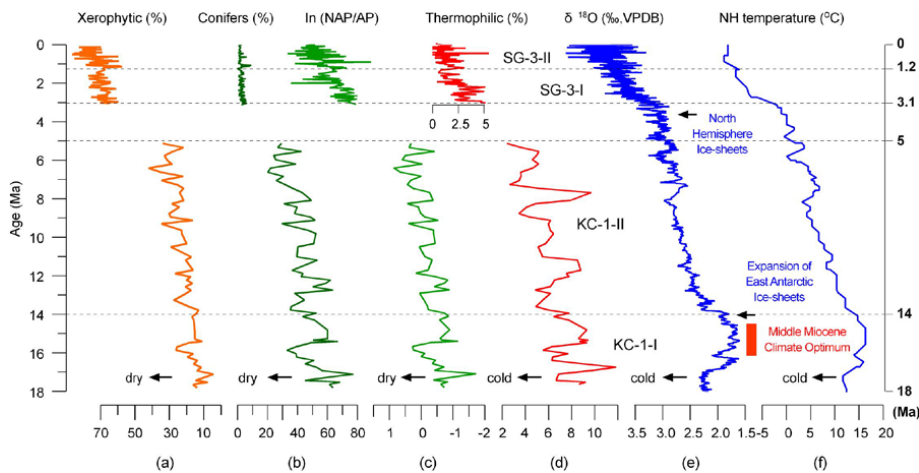
Figure 7. Comparison of (a) xerophytic percentages, (b) conifer percentages, (c) ln (NAP/AP) (NAP: non-arboreal pollen; AP: arboreal pollen) and (d) thermophilic element percentages, with (e) the global deep-sea oxygen isotope ( δ 18 O‰) records (20-point running average) (Zachos et al., 2008) and (f) temperature simulations using a 1-D ice-sheet model (de Boer et al., 2010).